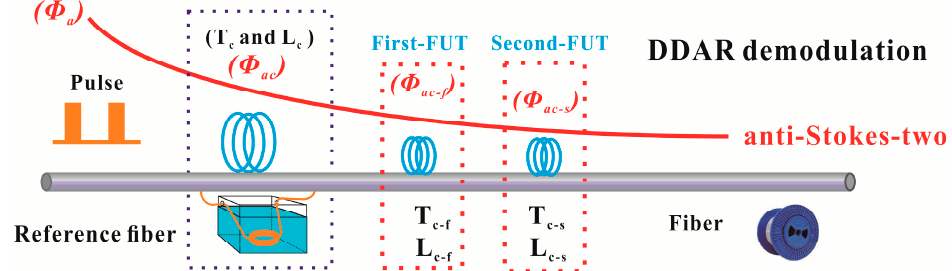
Figure 10. The DDAR demodulation schematic diagram for SDP scheme.